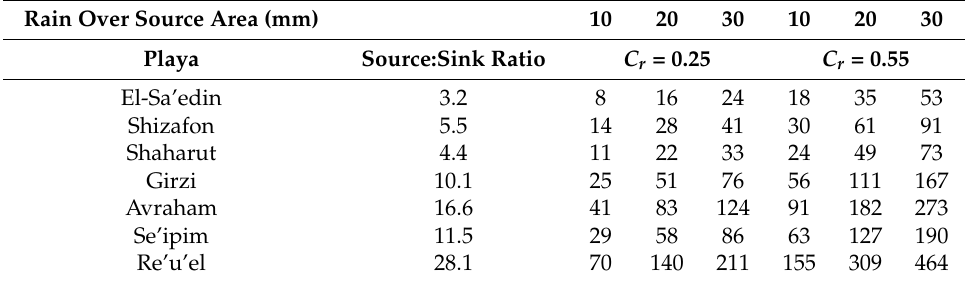
Table 4. Potential water column depth (mm) over the recharge playa’s bed due to runoff generated from adjacent hillslopes, and according to rainfall depth and runoff coefficient ( C r